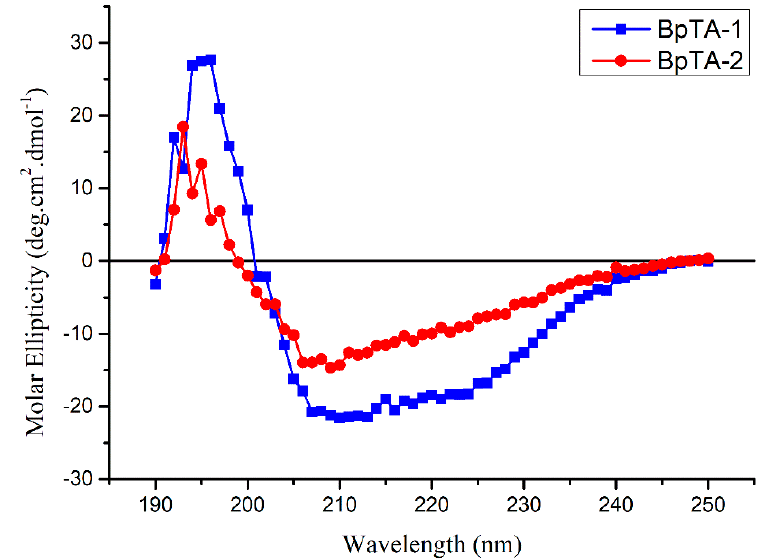
Figure 5. Ultraviolet circular dichroism (UV-CD) spectrum of purified BpTA-1 and BpTA-2 at room temperature and pH 7.0.